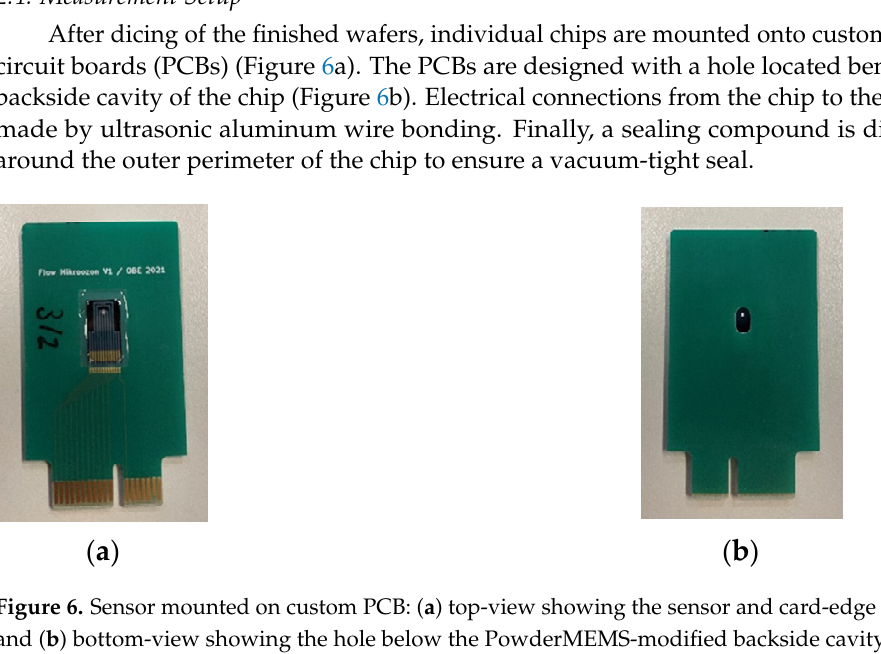
Figure 7. Custom vacuum chuck without ( a ) and with ( b ) mounted PCB. By connecting the pink tubing to a turbopump, a vacuum can be created inside the porous PowderMEMS structure located beneath the thin-film membrane.